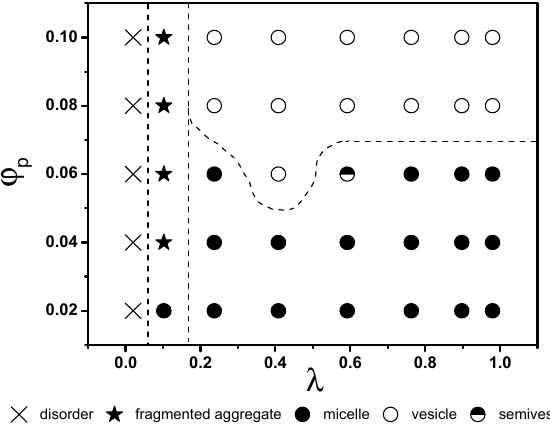
Figure 2. The effects of polymer concentration and interaction energies among beads on the equilibrium aggregate structures. Solid and open symbols correspond to micellar and vesicular aggregates, respectively.